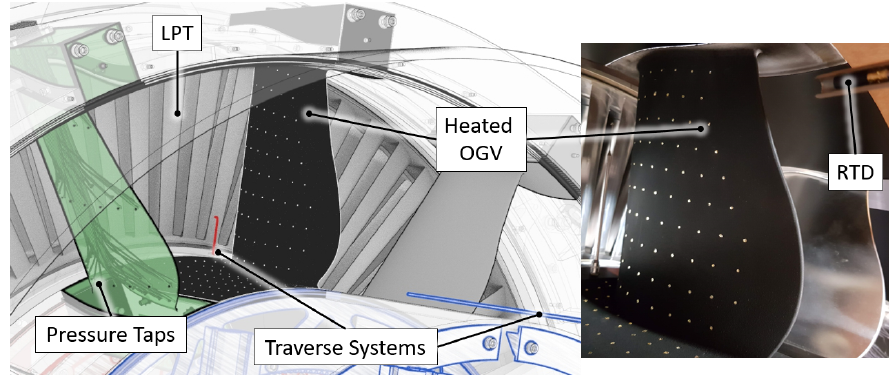
Figure 2. Schematic illustration ( left ) and a photo ( right ) of the test section and instrumented